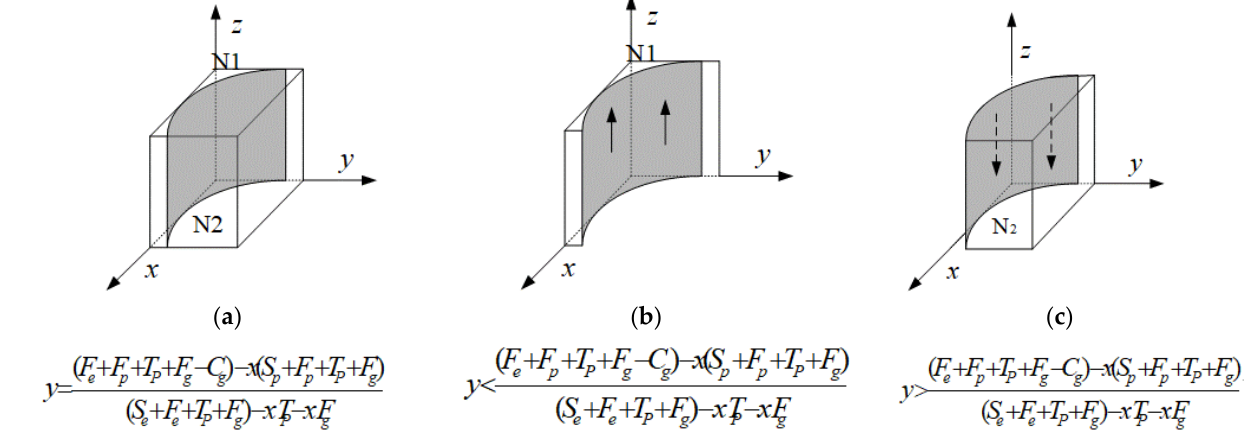
Figure 3. Phase diagram of the local government’s replication dynamics. Figure 3 indicates that the volumes of N 1 and N 2 are equal to the probability of strict supervision and loose supervision by the local government, respectively. The curved surface H ( x , y ) is parallel to the z axis. We discuss the intersection of the surface in the x–y plane. There are four possible situations, as shown in Figure 4, and so, the intersection may be expressed as follows, from which we can observe that the change of point coordinates is in accord with V N 1 .